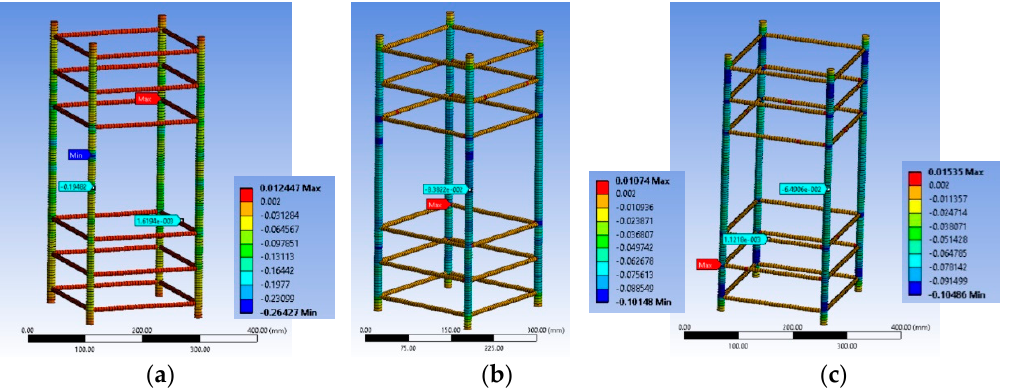
Figure 13. Variation of ε stirrup_max , ε long_mid and ε long_min for specimen ( a ) LSR-R-1-3-10b; ( b ) LSR-R-1-3-20b and ( c ) LSR-R-1-3-40b.